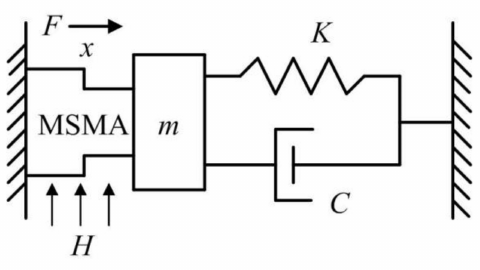
Figure 5. Equivalent mechanical model of the